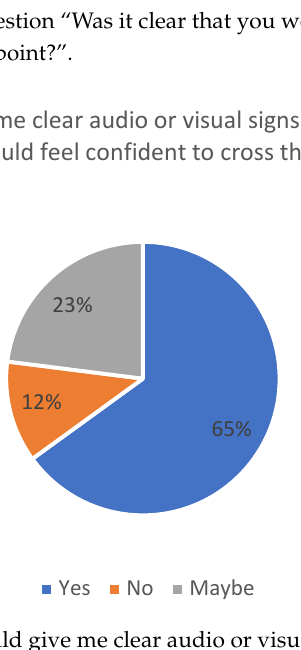
Figure 4. ”If the vehicle would give me clear audio or visual signs to safely cross in a non-crossing area, I would feel confident to cross there too”.